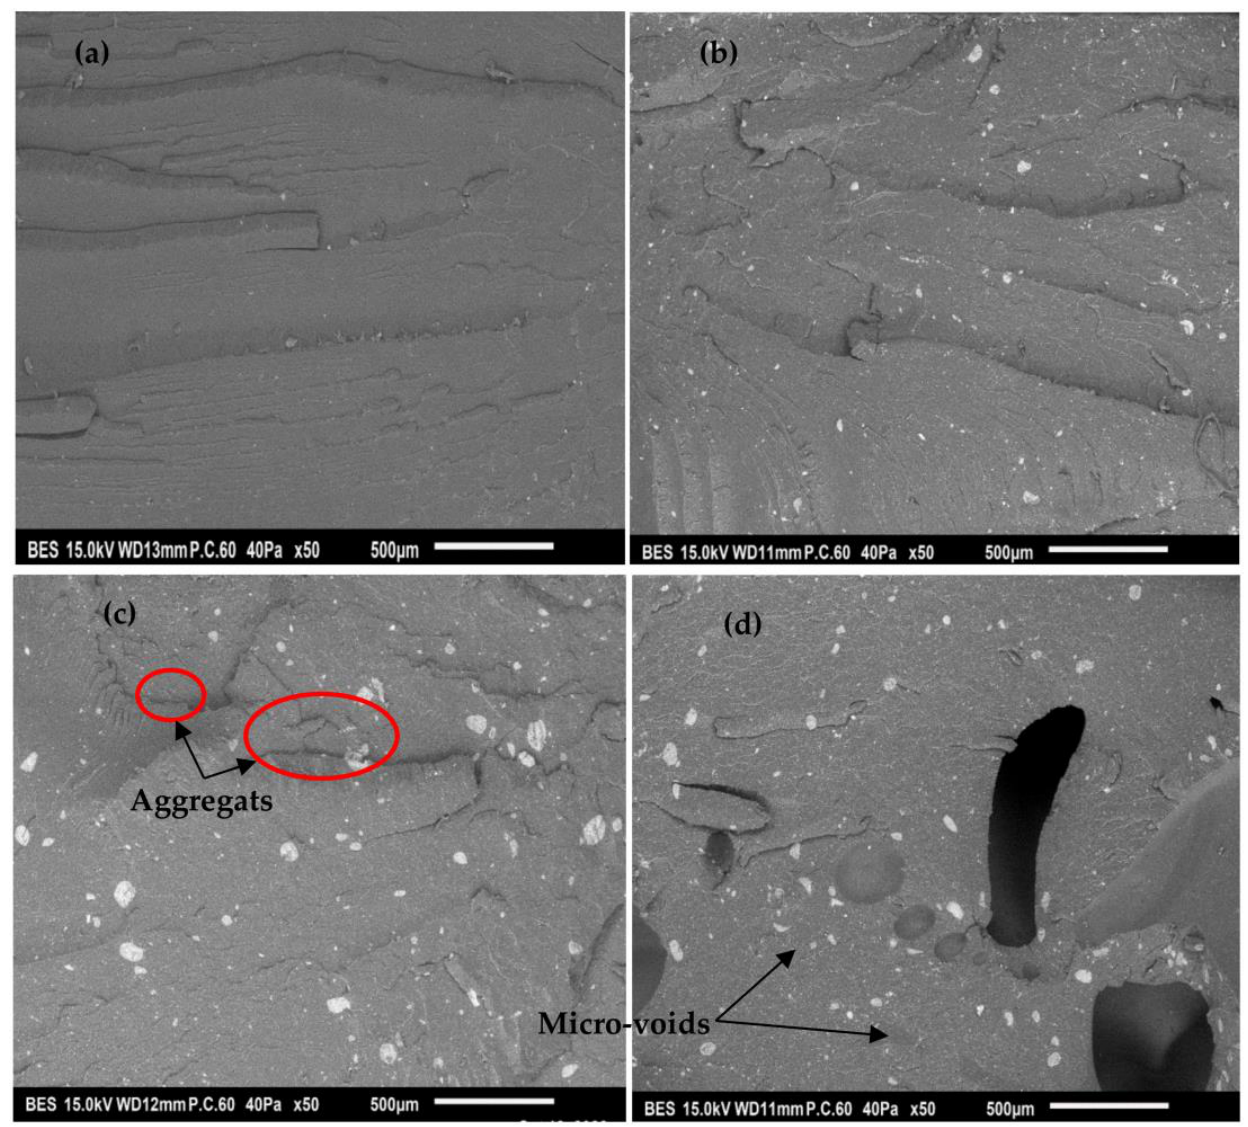
Figure 12. SEM images of the fractured surfaces after impact testing of: PLA ( a ), PLA/HAp-5 ( b ), PLA/HAp-10 ( c ) and PLA/HAp-15 ( d ); at 50×.